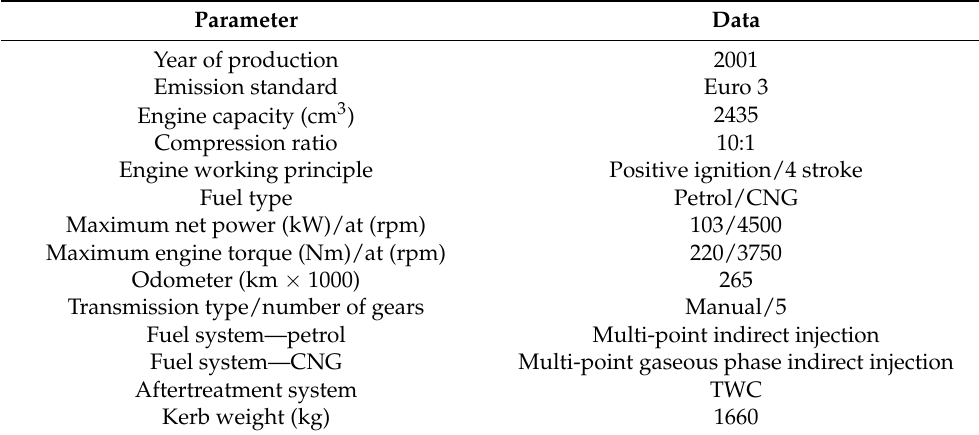
Table 1. Technical data of the tested vehicle.